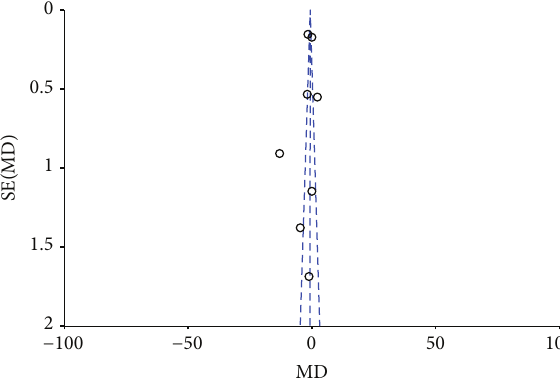
Figure 6: Funnel plot for meta-analysis of onset of motor anesthesia.